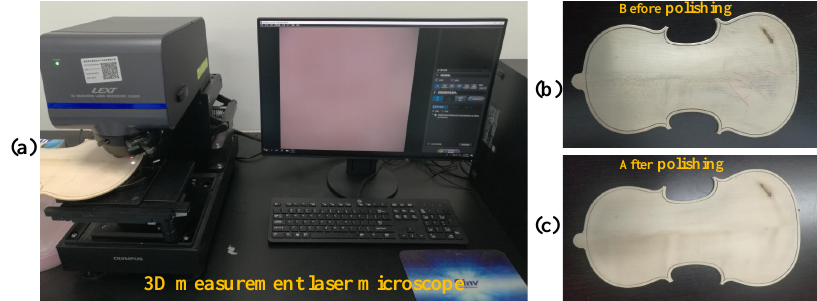
Figure 16. ( a ) OLYMPUS laser microscope, violin surface ( b ) before polishing, and ( c ) after